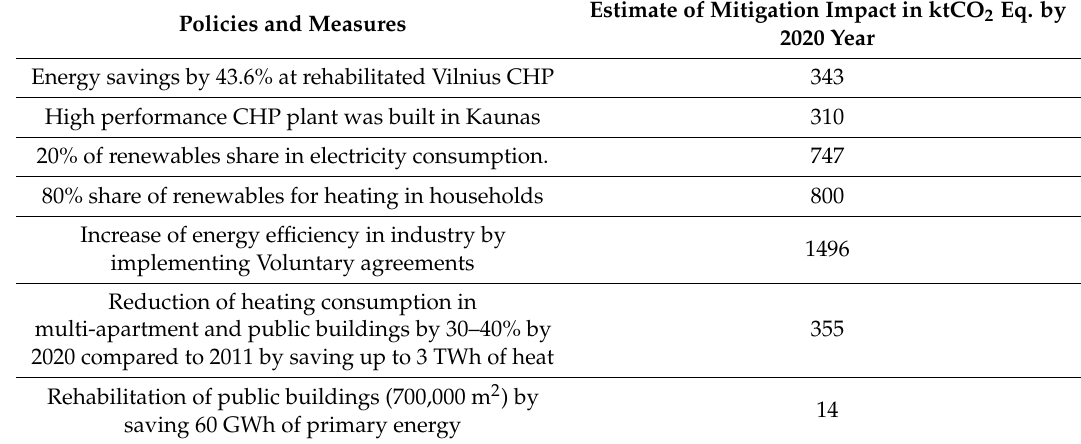
Table 7. Expected impact of policy measures on GHG emission reduction in the Lithuanian energy sector in 2020. Source: